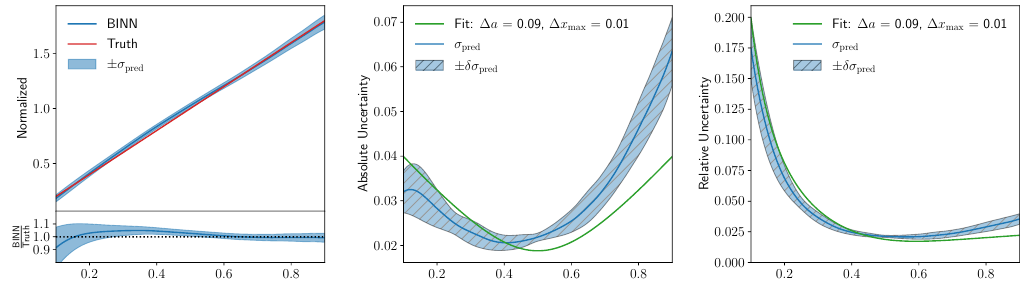
Figure 2: Density and predictive uncertainty distribution for the wedge ramp. In the left panel the density and uncertainty are averaged over several lines with constant y . In the central and right panels, the uncertainty band on σ variation. The green curve represents a two-parameter fit to